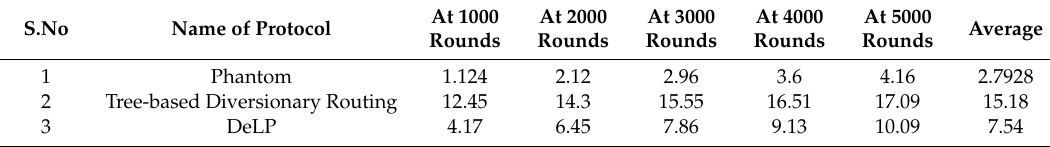
Figure 13. Net Energy consumption Vs Network lifetime (rounds). Table 5. Comparison of energy consumption after equal intervals.